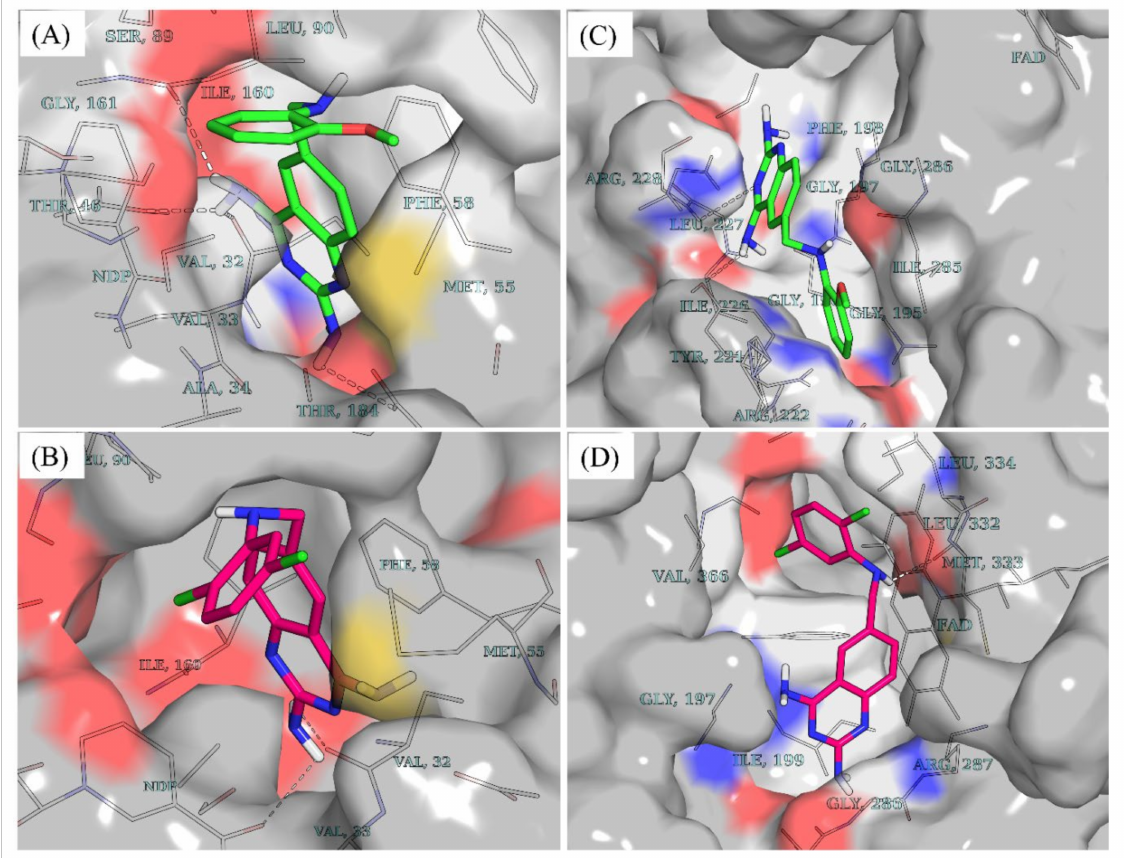
Figure 3. Docking poses and vina docking scores. ( A ) Docking pose of unprotonated compound 7 (cmpd_ 7 _unprot) in DHFR. ( B ) Docking pose of unprotonated compound 10 (cmpd_ 10 _unprot) in DHFR. ( C ) Docking pose of cmpd_ 7 _unprot in TR. ( D ) Docking pose of cmpd_ 10 _unprot in TR. Compound 7 is colored in green while compound 10 is colored in dark pink. Cmpd_ 7 _prot_2 and cmpd_ 7 _prot_4 stand for compound 7 protonated, respectively at position 2 and 4 of the 2,4-diaminoquinazoline ring while cmpd_ 7 _unprot refers to the unprotonated form of compound 7 . The same notations apply to compound 10